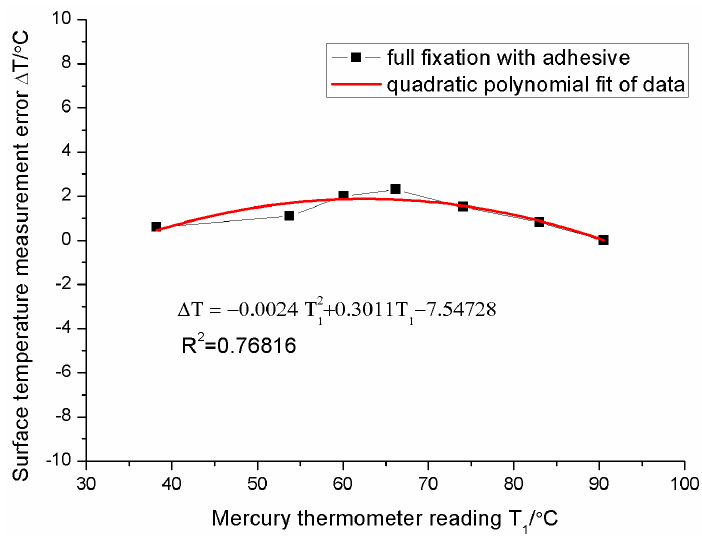
Figure 12. Surface temperature measurement errors of sensor with the full fixation.